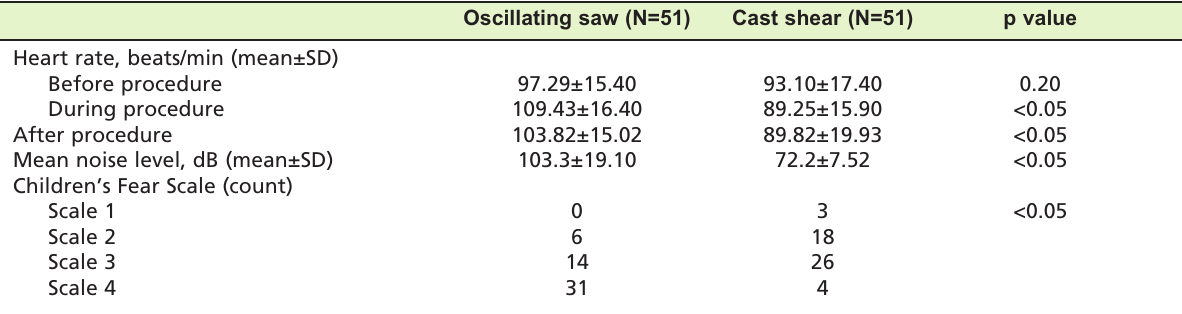
Comparison of the children’s heart rate, level of anxiety and cast room noise level between the oscillating saw versus Table II: cast shear group